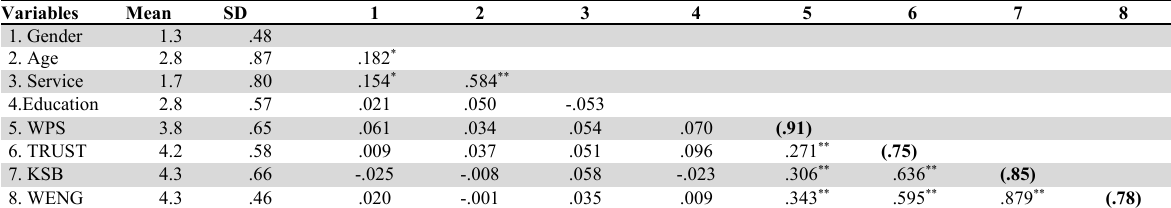
Mean, Standard Deviation, Correlation, and reliability Variables Mean SD 1